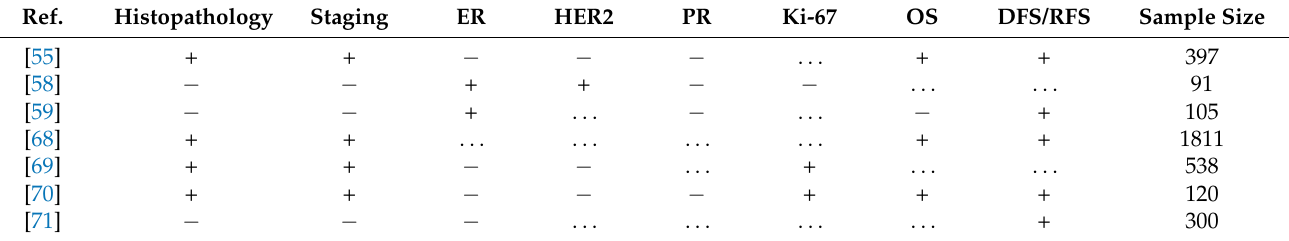
Table 1. The correlation of MACC1 expression with clinical features of breast